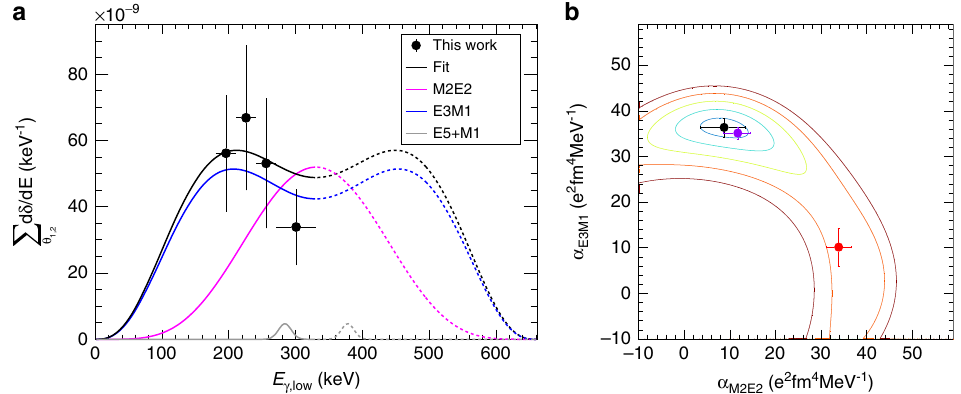
Fig. 5 Multipole nature of the γγ / γ decay. a Energy-sharing distribution for the two photons in the double- γ decay compared with the expected energy distributions of pure M2E2 and E3M1 decay, as well as the two-step E5 + M1 decay where the measured intensity 8 has been subtracted from the 300 keV data point. The data points correspond to the sum of the differential branching ratio de fi ned in Eq. (4) over all the available angles. b Two-dimensional goodness-of- fi t, χ 2 , plot for the two α parameters with the experimental data. The contours are separated by one standard deviation. The data from the present work is shown as a black point, data from reference 11 is shown as a red point, and a fi t with the two data sets combines is shown as a purple point. The error bars represent the one standard-deviation statistical uncertainty, except the error bars in E γ ,low that represent the width of the energy